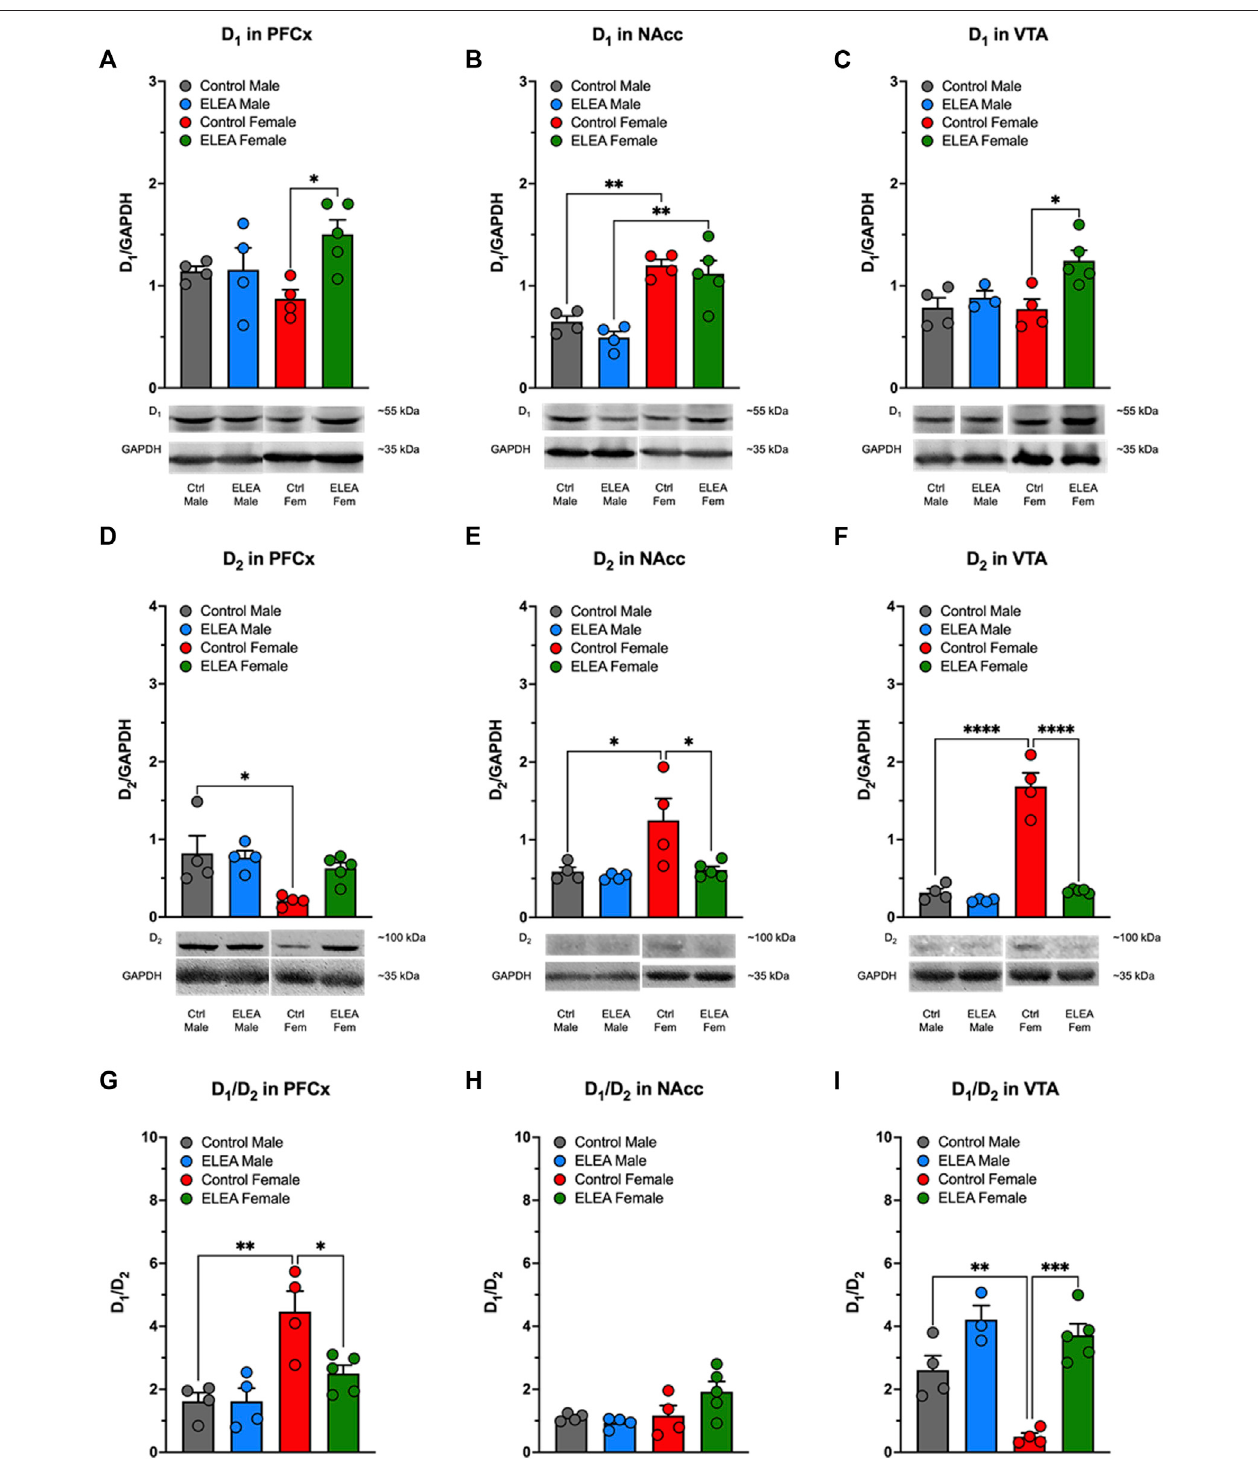
FIGURE 6 | Effect of perinatal antibiotic exposure on the protein levels of the mesocorticolimbic dopaminergic system. Early life antibiotic exposure increased D1 protein levels ofPFCx (A) and VTA (C) in adult female rats. Both control and antibiotic exposed females had higher levels ofD1 in NAcc than their male counterparts (B) . PFCx D2 protein levels were higher in control males than in control females (D) . In both, NAcc (E) and VTA (F) , control females had higher D2 protein level than control males, but antibiotic exposure during early life decreased protein expression. PFCx D1/D2 ratio was higher in control females than control males, but antibiotic exposure decreased the ratio in females (G) . There were no signi fi cant changes in D1/D2 ratio of NAcc (H) . VTA D1/D2 ratio was lower in control female than in control male, but antibiotic exposure increased the ratiooffemale rats (I) . (Control male, n = 4; ELEA male, n = 4; control female, n = 4; ELEA female, n = 5; * = p < 0.05; ** = p < 0.01; *** = p < 0.001; **** = p < 0.0001).